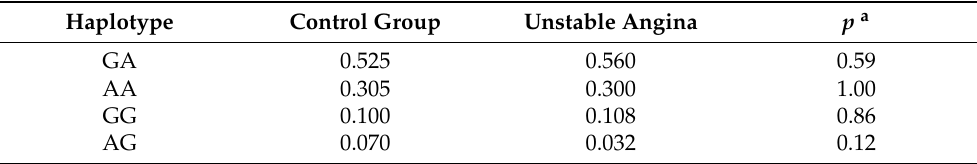
Table 4. Haplotype frequency of TGFBR2 rs6785358 and rs9838682 in unstable angina and control group.